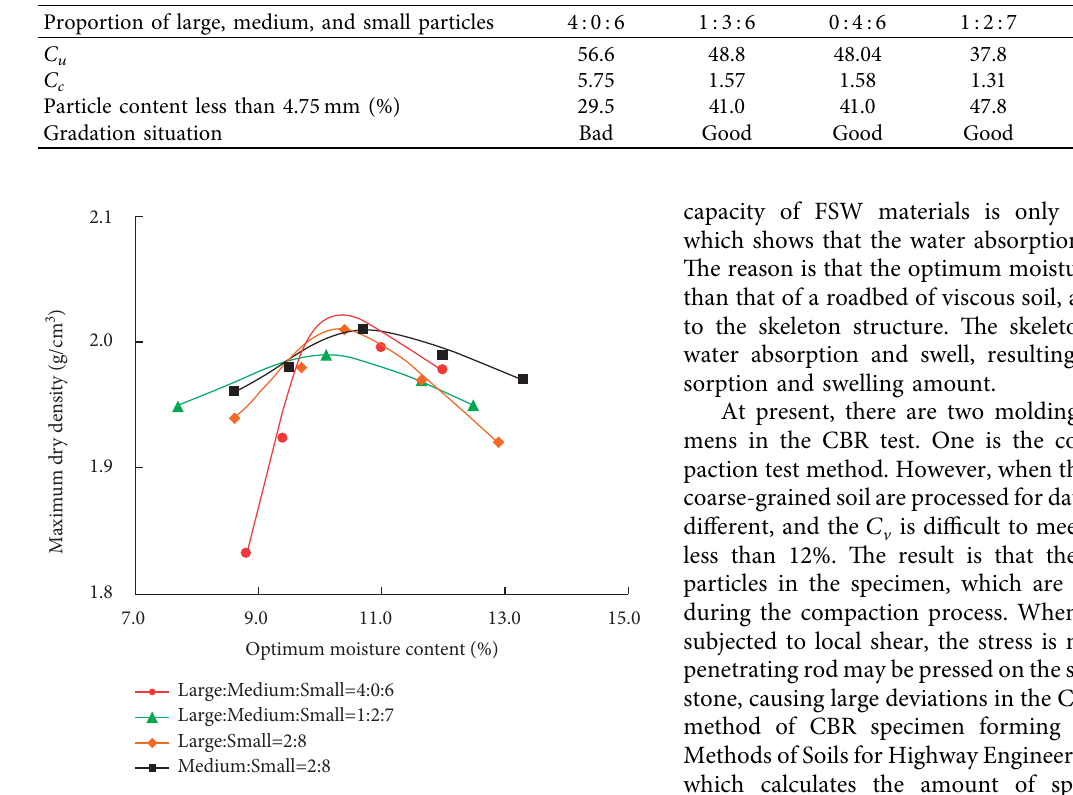
Figure 4: Compaction test results of